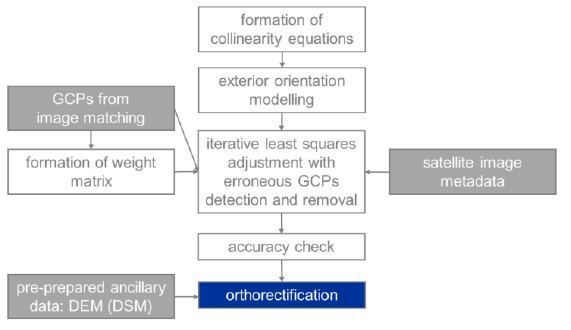
Figure 8. Workflow of the Physical Sensor Model and Orthorectification